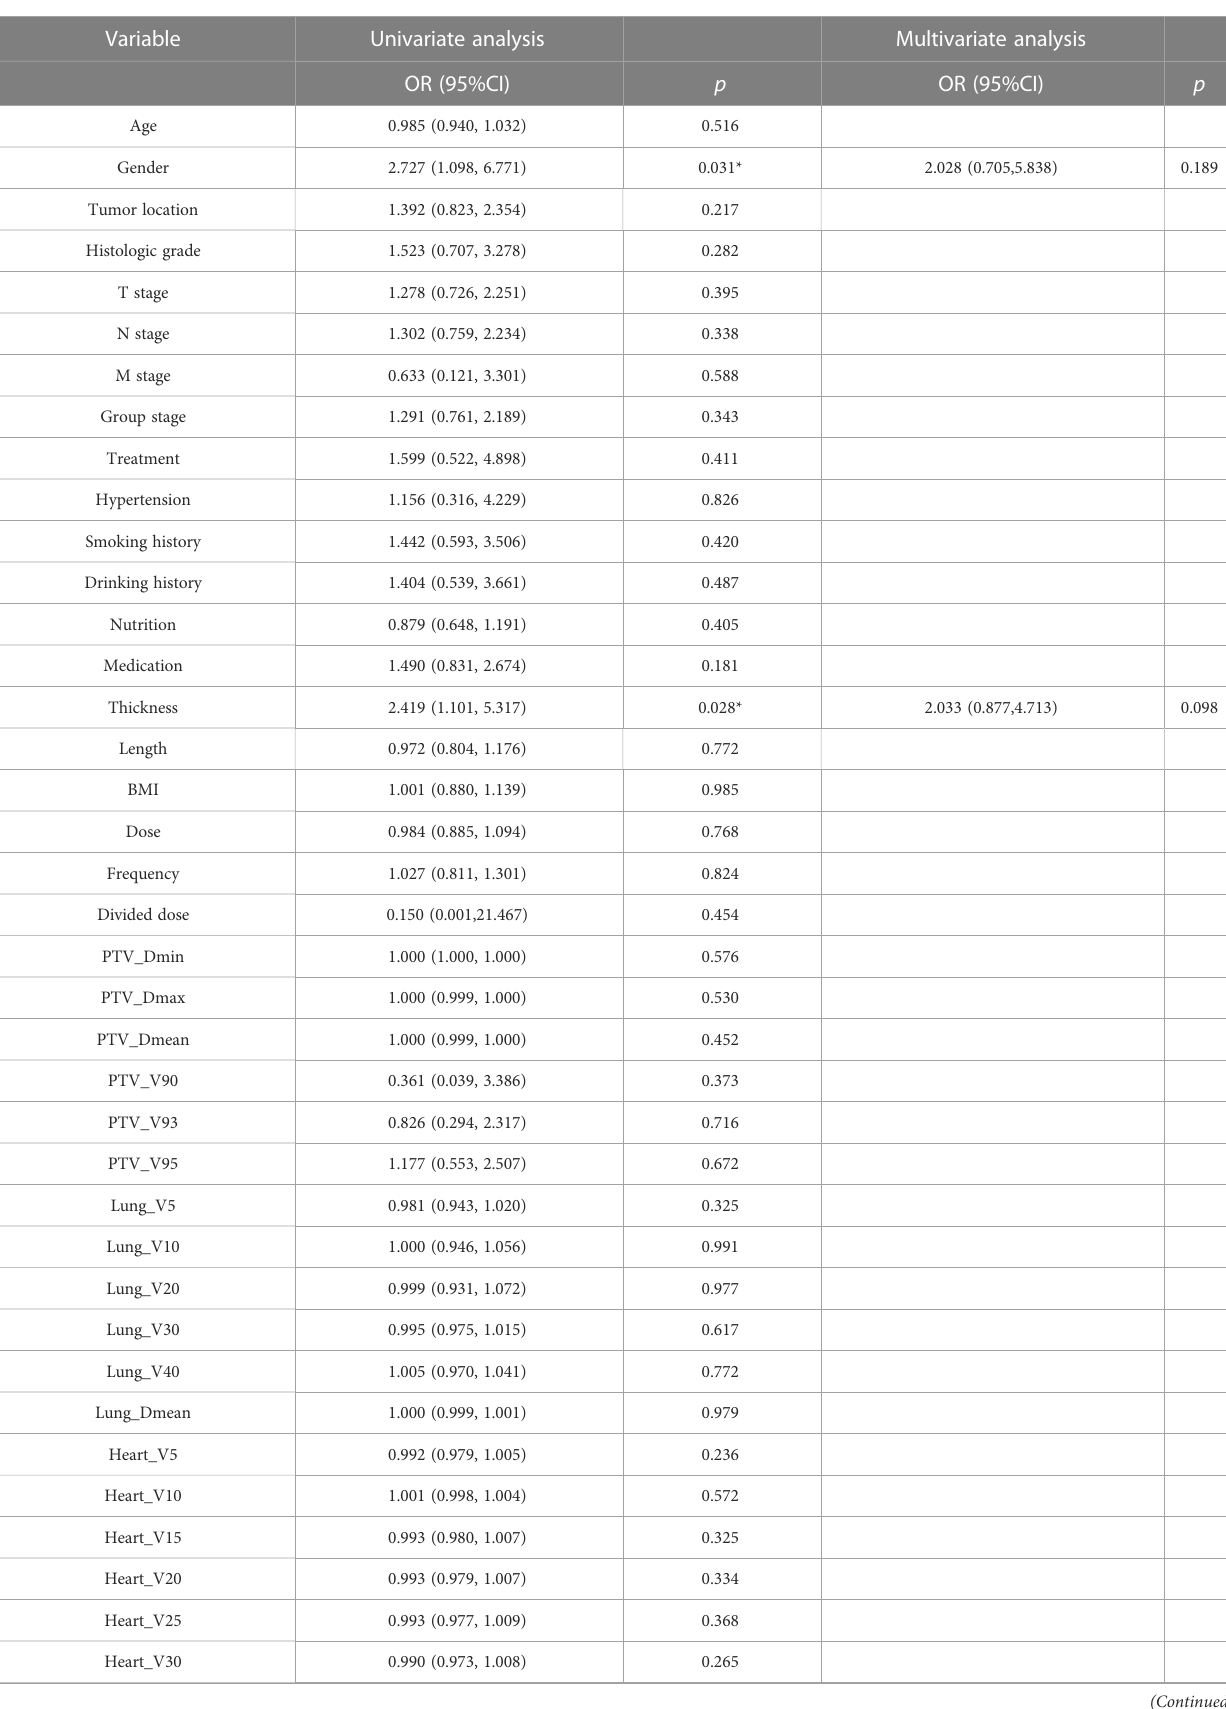
TABLE 2 Univariate and Multivariate logistic regression analysis in the training